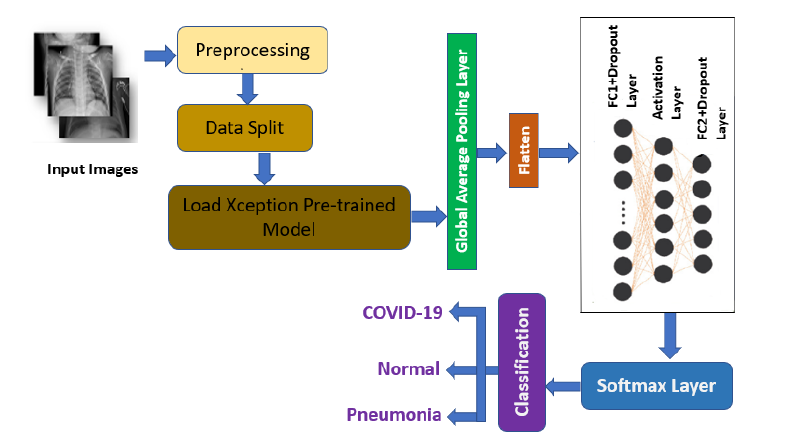
Figure 1. A block diagram of the structure of the proposed classification